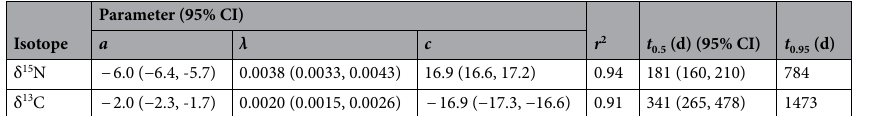
Table 3. Parameter estimates and calculated turnover rate metrics from time-based exponential fit models for δ 15 N and δ 13 C values of muscle in California yellowtail ( Seriola dorsalis ). Estimated half-life ( t 0.5 ) and time for 95% isotope turnover ( t 0.95 ) (days) is shown for each isotope.